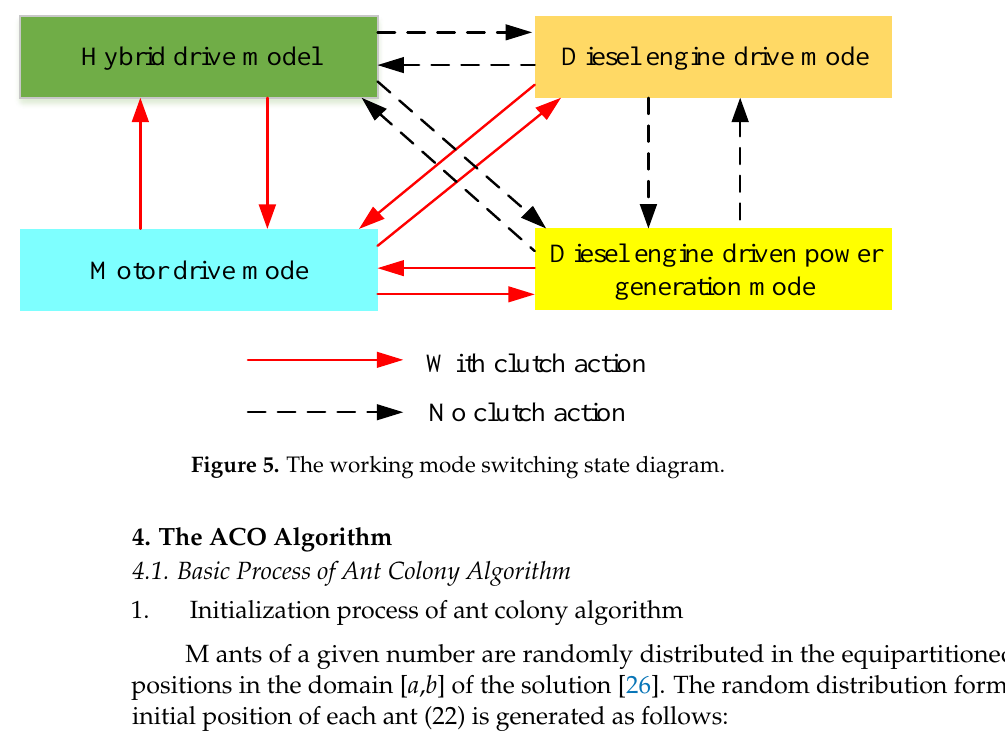
Figure 4. The equivalent fuel consumption minimization strategy (ECMS) flow chart considering mode switching.